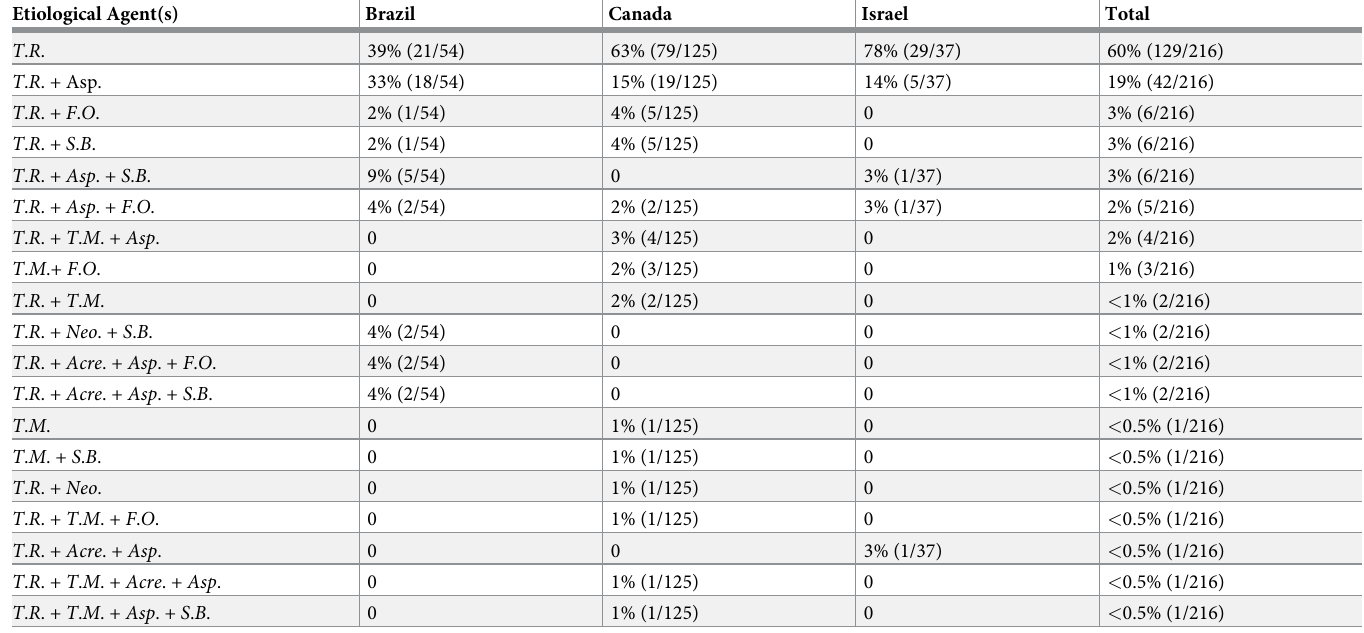
likely to have a mixed result detected in samples from Brazil, but more likely a dermatophyte result in samples from Canada and Israel (Table 1). In all three countries combined, as well as individually, the frequency of dermatophyte infection increased significantly with age (Table 3). Similarly, the frequency of mixed infec- tions increased significantly with age in all countries combined (Brazil, Canada and Israel) and in Brazil and Canada when considered separately (Table 3). The relationship was non-signifi- cant for Israel alone ( P = 0.236), although our result for Israel supports the trend in which fre- quency of mixed infections increases with age (Table 3). The non-significant finding for Israel could be an artifact of the small number of mixed infections obtained. All NDM infections were mixed (detected with a co-infecting dermatophyte(s); Tables 1 and 2). The five NDMs that were identified were Aspergillus spp .at 30% (64/216), S . brevicaulis Table 2. Etiological agent(s) of global onychomycosis by country. Etiological